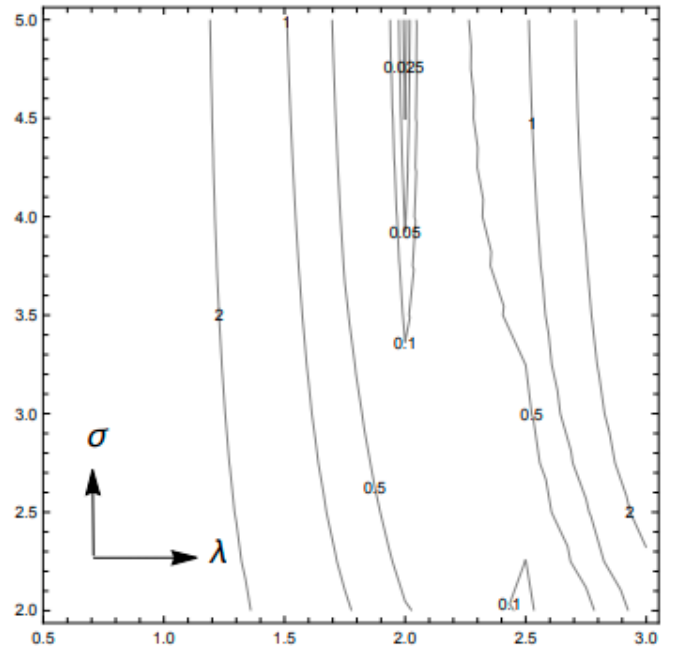
Figure 16. Plot of the cost function based on Equation (32) for the nonchaotic regime using L-LOM (3) with observations in space-time. The minimum is located at λ = 2.0, σ = 4.4 ( λ the horizontal axis and σ the vertical axis).